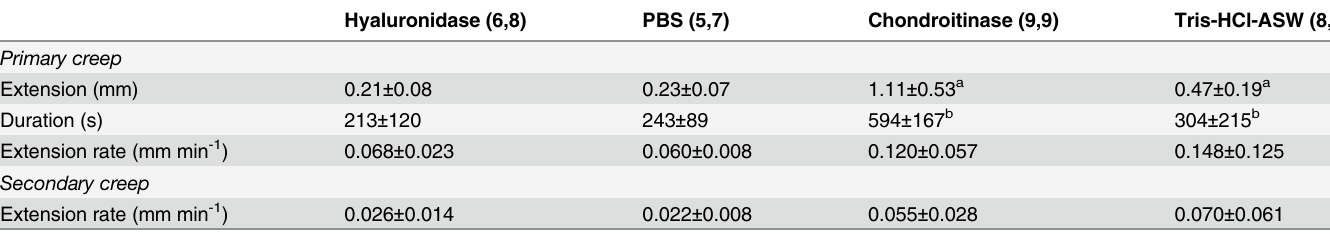
Table 1. Effects of enzymes on the creep behaviour of P. lividus CDs.